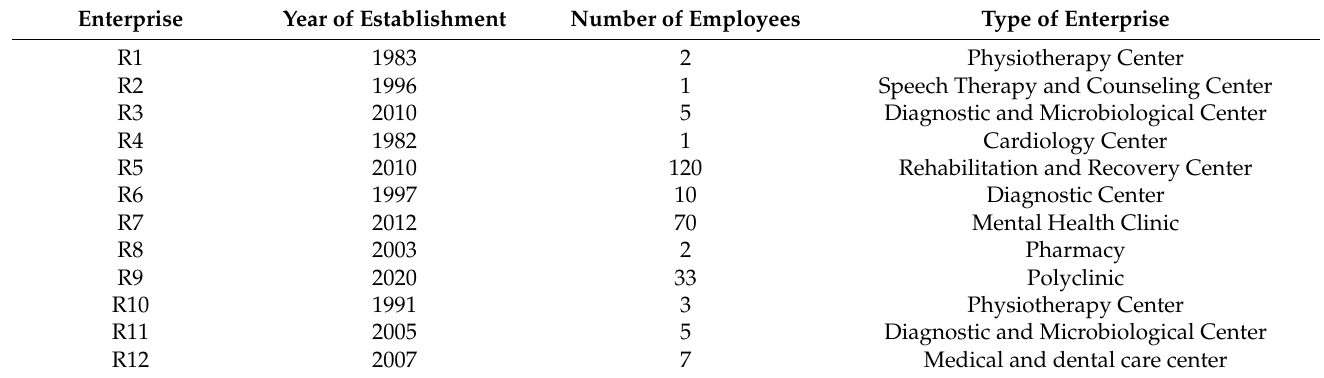
Table 1. Characteristics of the selected healthcare